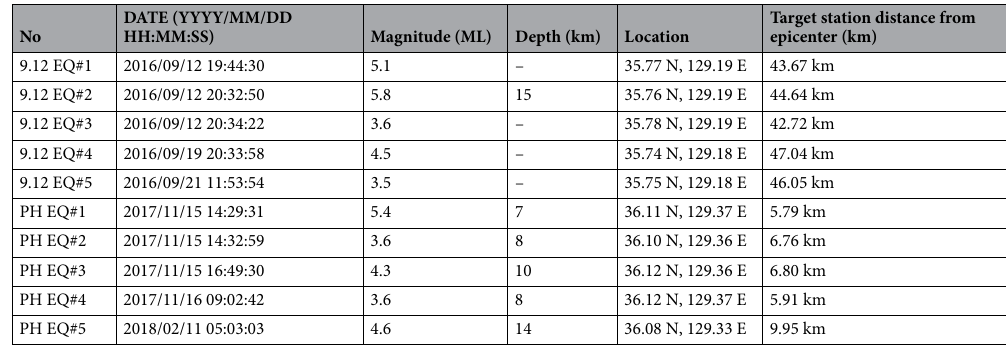
Table 2. List of 9.12 and PH EQ occurrence.